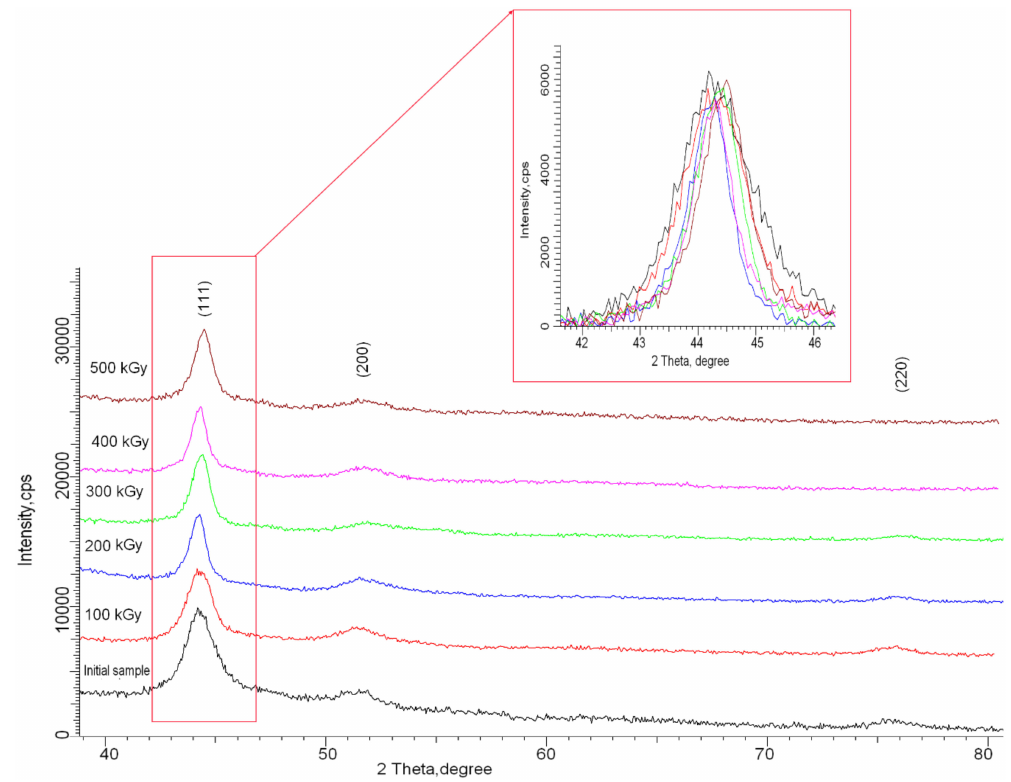
Figure 2. X-ray di ff raction patterns of the studied samples before and after